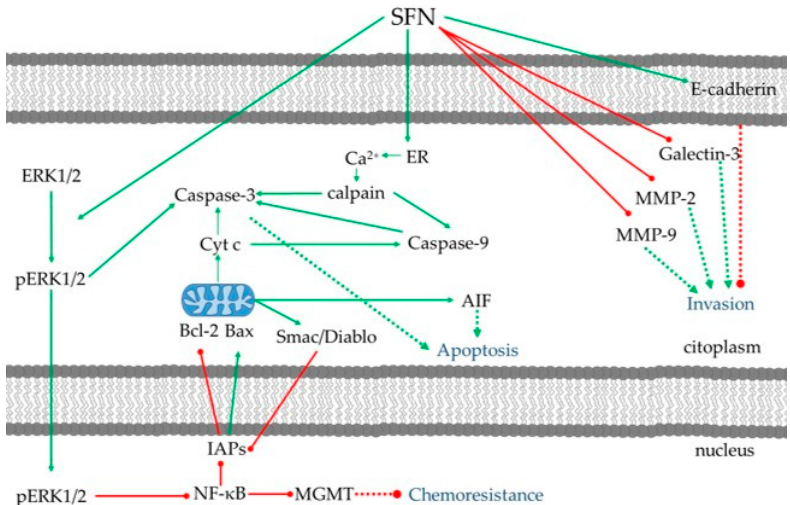
Figure 2. Summary of the multiple signaling pathways of SFN in glioblastoma (GBM). SFN may induce apoptosis through endoplasmatic reticulum (ER) stress, or through the inhibition of survival signals and promotion of pro-apoptotic molecules. SFN is also able to reduce tumor invasiveness and to counteract chemoresistance.